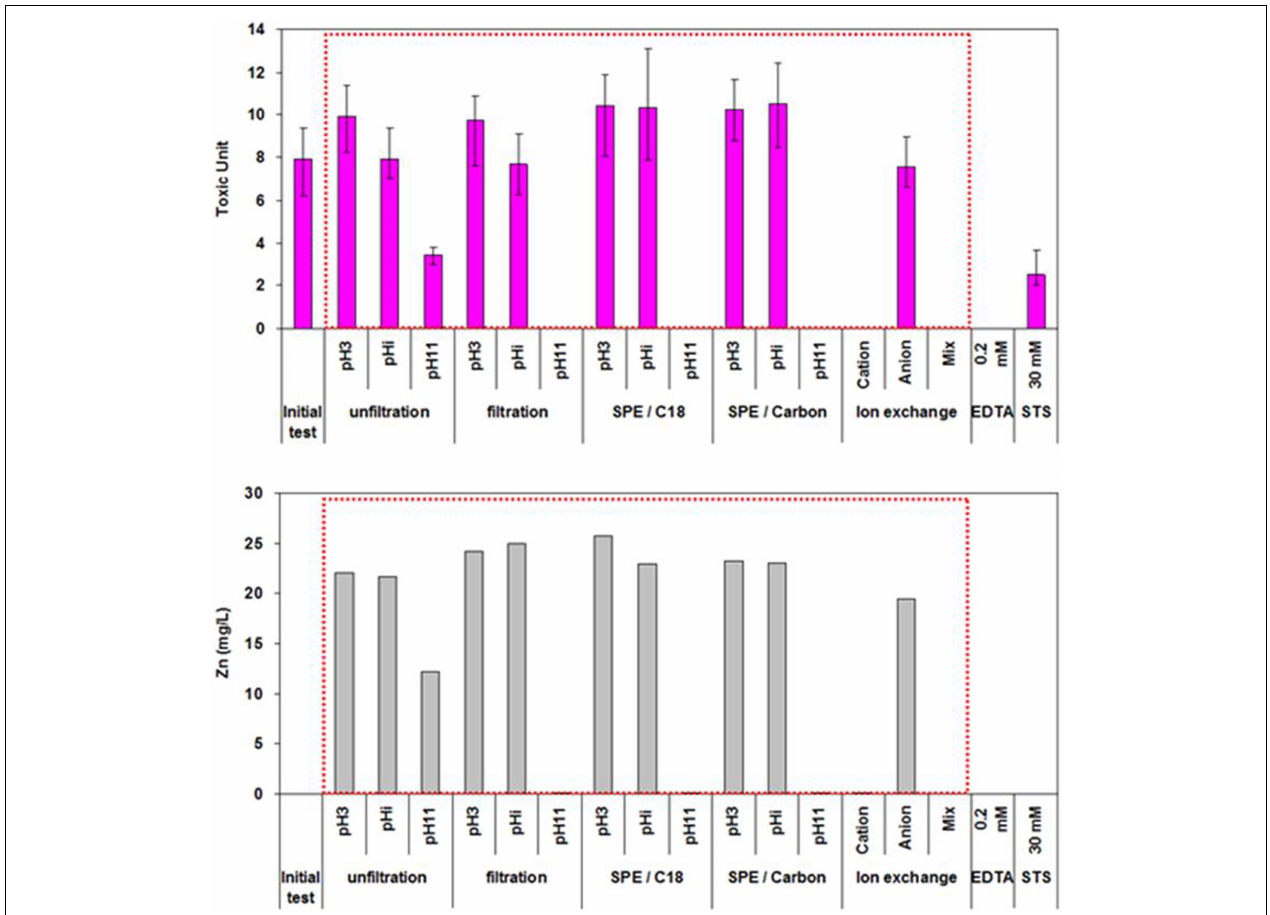
FIGURE 4 | Phase I and II toxicity characterization and identification (TIE) of final effluent (March 2008) using U. pertusa . The error bars represent 95% confidence intervals.